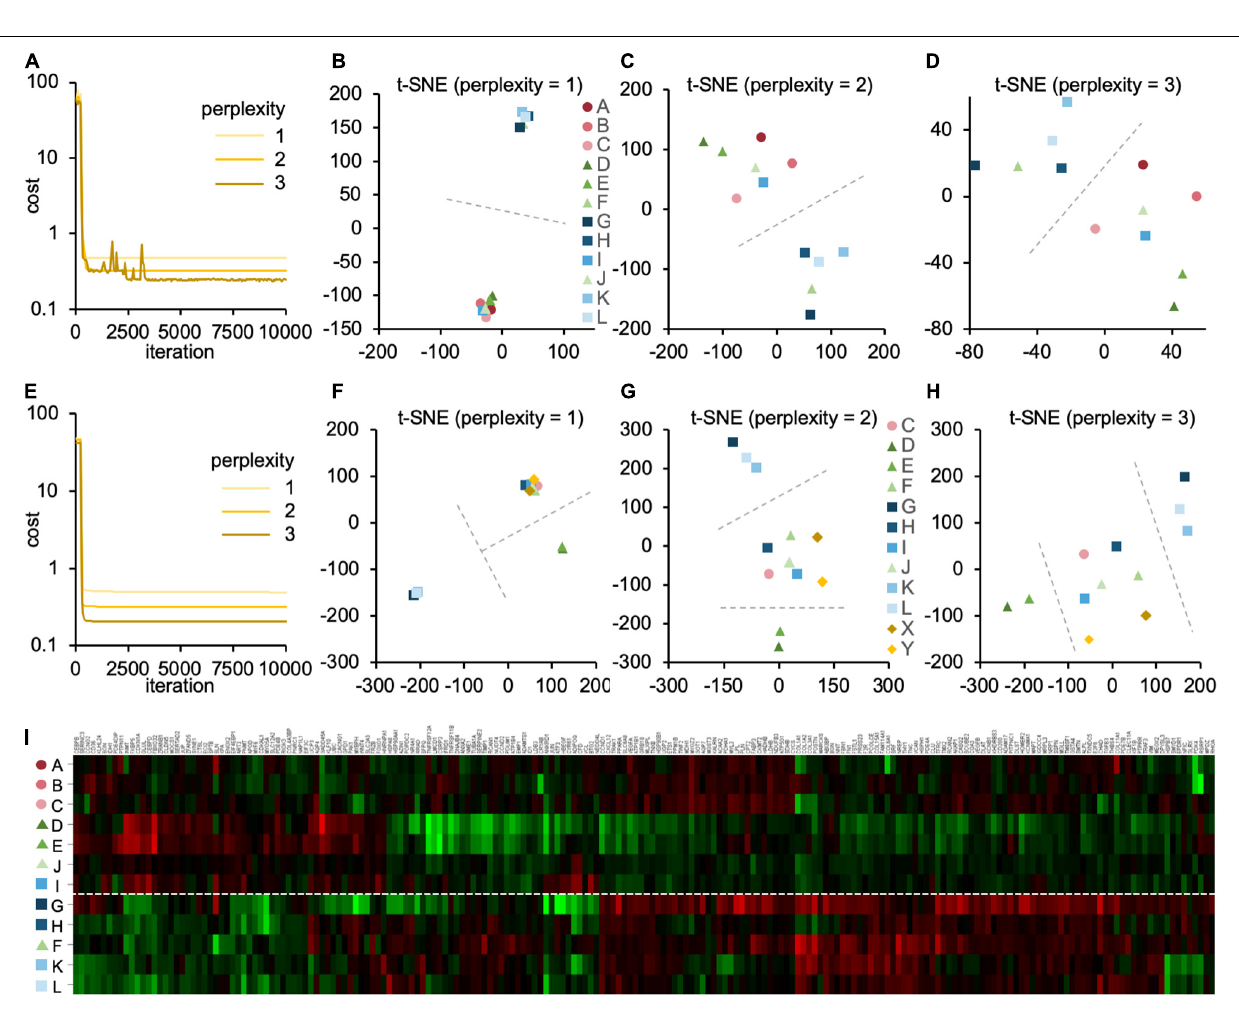
Frontiers in Cell and Developmental Biology |